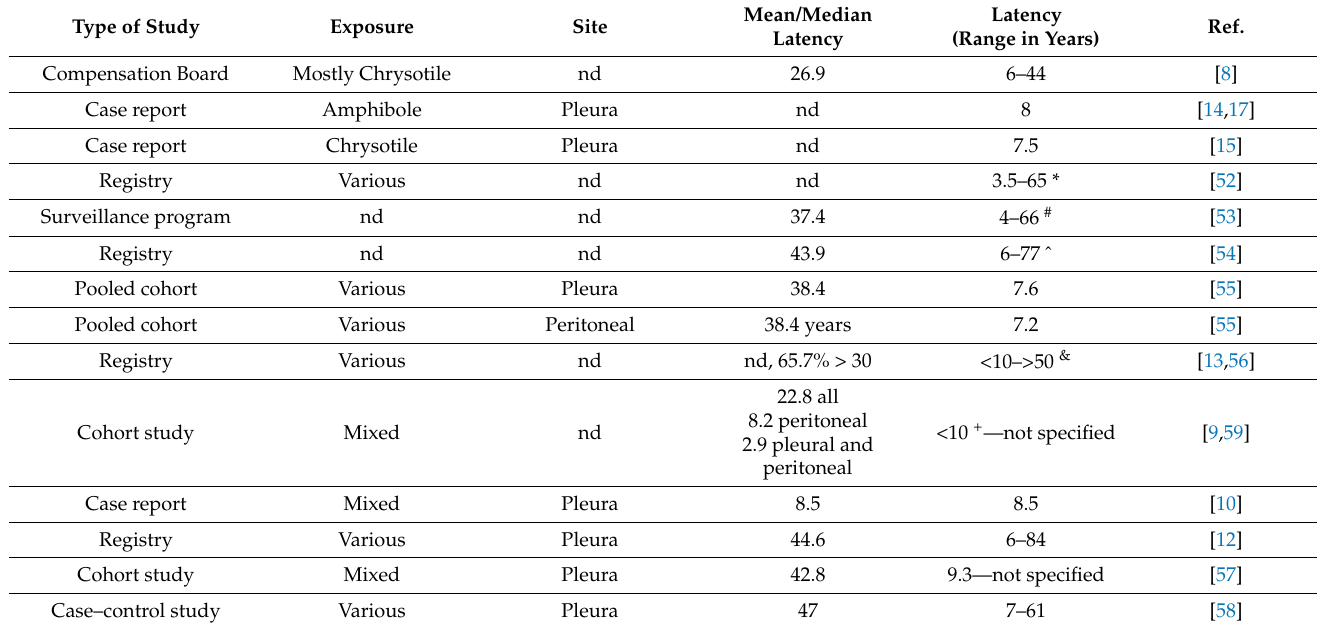
Table 1. Summary of studies reporting less than 10-year latency. Several of the studies did not specify maximum latency. Abbreviations: nd = no data, * the two recorded cases with <10 years latency (3.5 and 7.5 year) had chrysotile exposure; # 4 cases <10 years; ˆ 2 cases <10 years; & 1.8% cases (6 of 332 cases) <10 years; + 24 of 614 cases <10